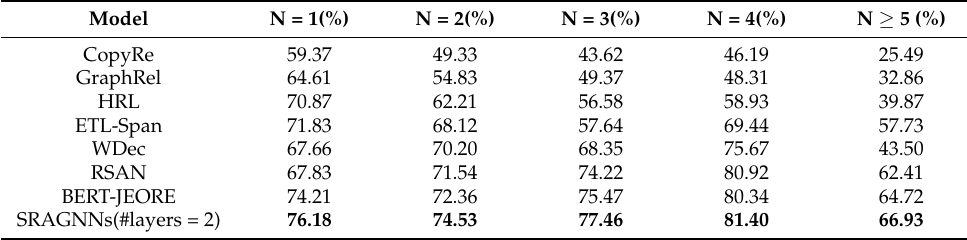
Table 6. Relation extraction on sentences with different numbers of triplets.